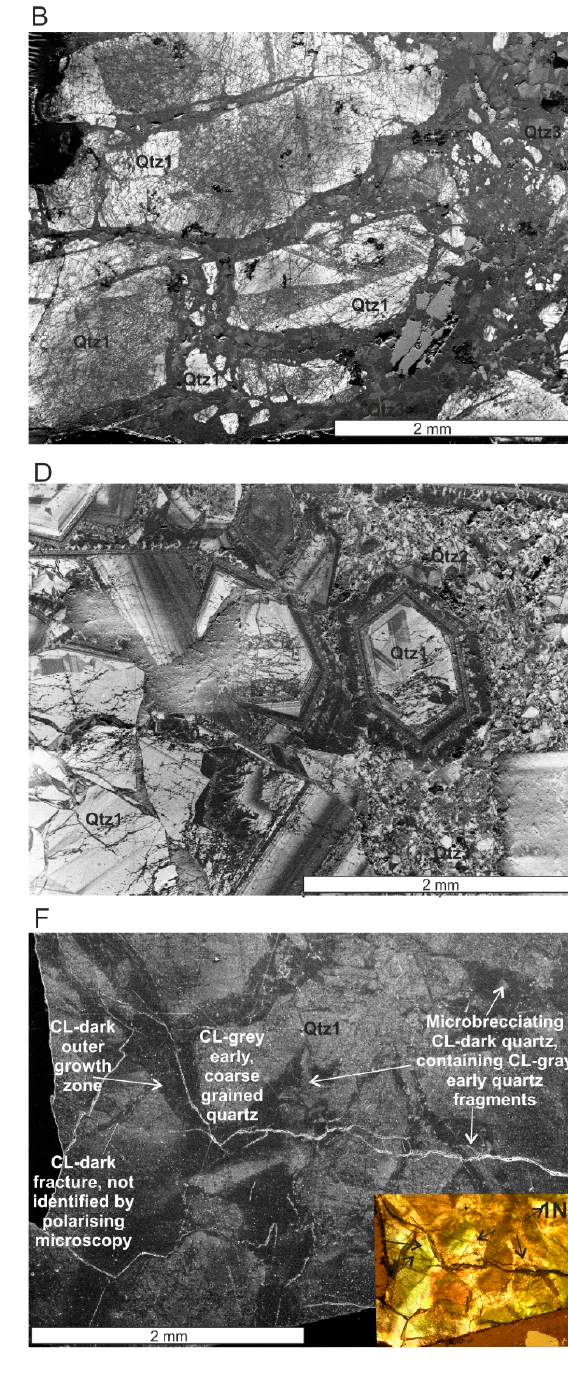
Figure 4. Petrographic and SEM-CL characteristics of quartz from the ore deposits studied. ( A ) CL-grey early quartz (Qtz 1) with euhedral growth zones. CL-dark microfractures occurred only in the core of early quartz (Reppia). ( B ) CL-bright early quartz (Qtz 1) was cut by cobweb textured CL-dark microfractures. Late CL-grey, mottled textured quartz (Qtz 3) was microbrecciating; fragments of early quartz (Qtz 1) could be unequivocally identified (Campegli). ( C ) CL-grey, mottled textured early quartz (Qtz 1) with a few euhedral growth zones. CL-dark and younger CL-bright late microfractures crosscut the whole sample (Vigonzano). ( D ) Early quartz (Qtz 1) showing euhedral growth zones. CL-dark microfractures occurred in the core of early quartz. A mosaic of medium (Qtz 2) and fine grained (Qtz 3) quartz with irregular growth zones filled the space among the coarse crystals (Boccassuolo). ( E ) CL-grey early quartz (Qtz 1) with a CL-dark growth zone. Later CL-dark quartz (Qtz 3) was microbrecciating. The breccia may contain fragments of the early quartz (Bargone). ( F ) CL-grey early quartz (Qtz 1) with a CL-dark microfracture. Later CL-dark quartz (Qtz 3) was microbrecciating. The breccia may contain fragments of the early quartz